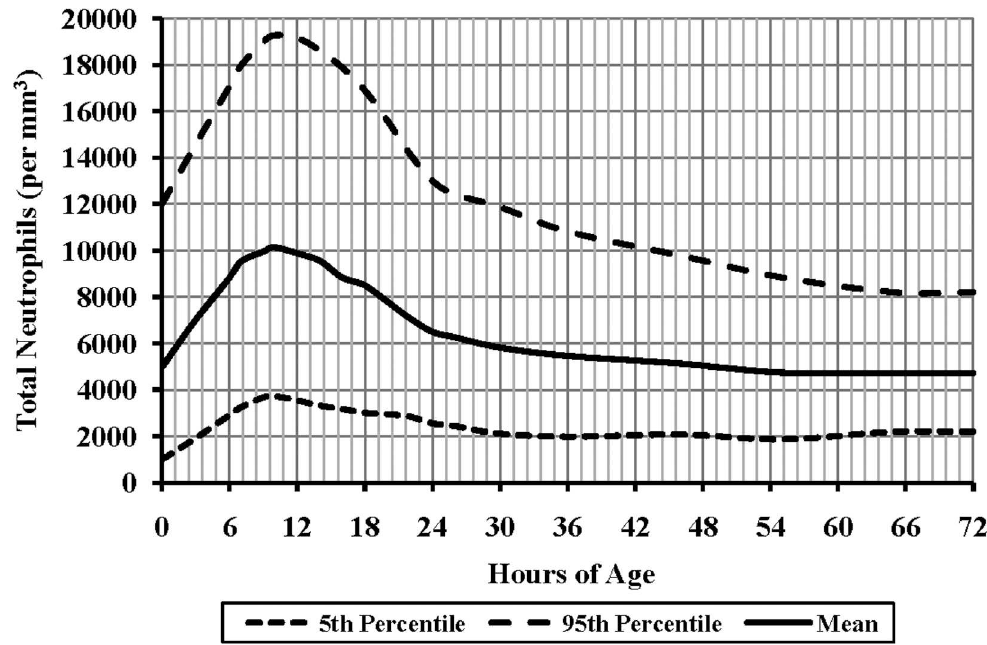
Fig 2. Referencerange for absolute total neutrophils (ATN) during the first 72 h after birth of very low birth weight (VLBW) infants. A total of 1472values were obtainedfor the analysis.The 5 th percentile, 95 th percentile,and averageare shown.